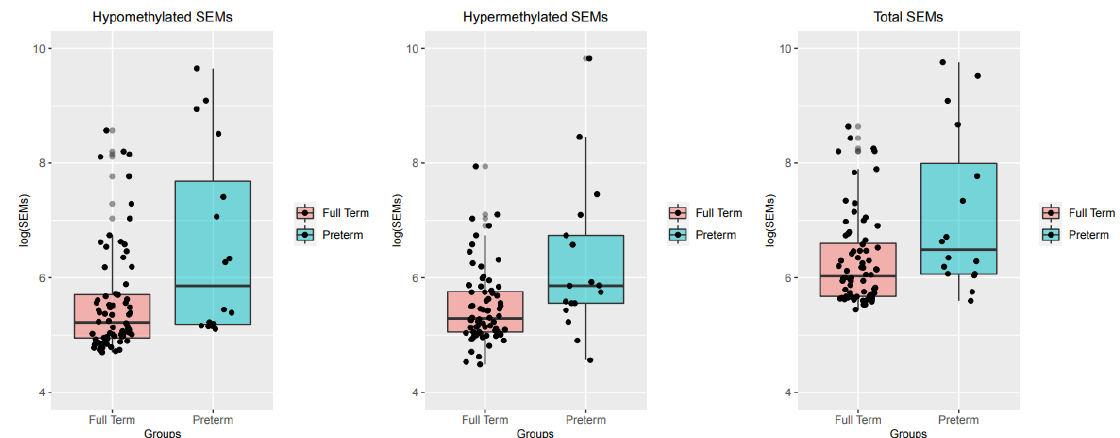
Figure 5. Boxplot showing the distribution of SEMs between preterm and full-term babies. SEMs are divided in Hypomethylated and Hypermethylated and Total. The thick horizontal line represents the median of the distribution while the box represents the interquartile range. Whiskers are set as the default option for boxplot function and extend to the most extreme data point which is no more than 1.5 times the interquartile range from the box. Open circles represent outliers, (single values exceeding 1.5 interquartile ranges).